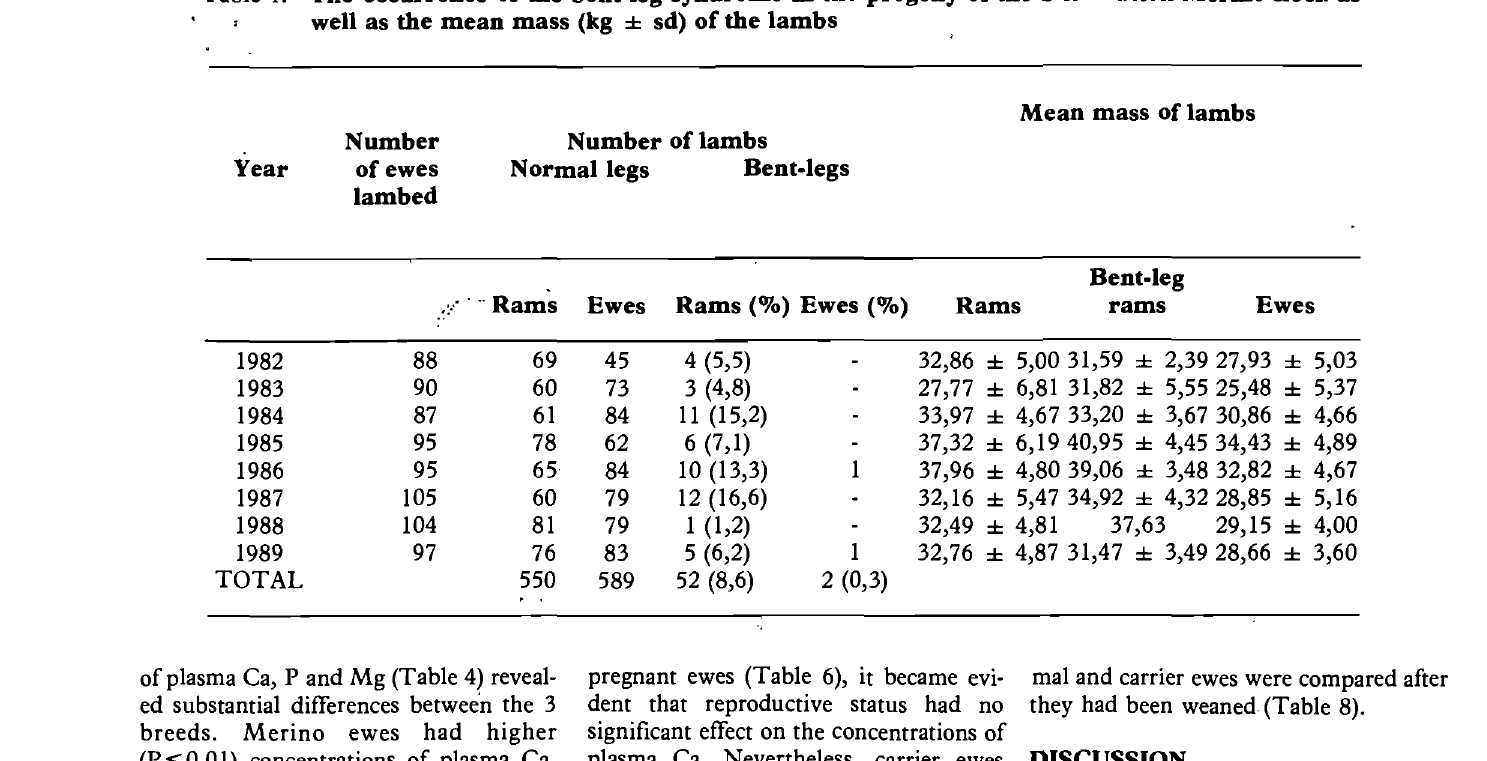
Table 1: The occurrence of the bent-leg syndrome in the progeny of the ~ A Mutton Merino t10ck as well as the mean mass (kg ± sd) of the lambs